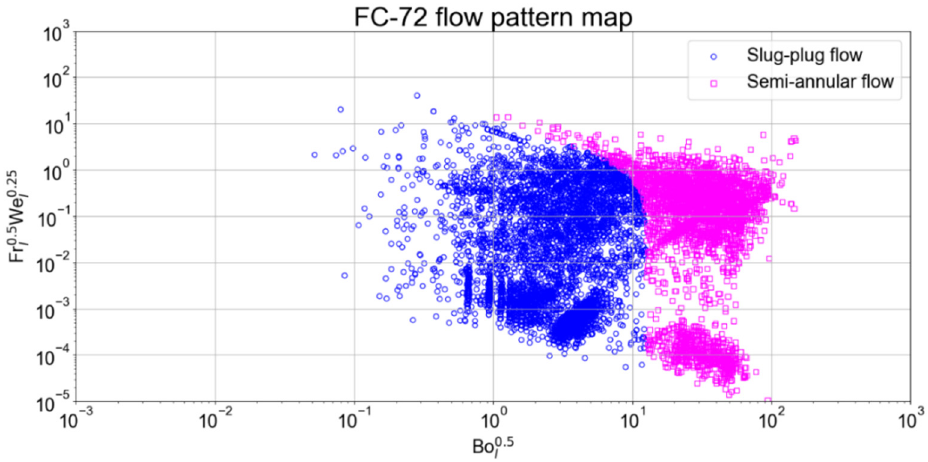
Figure 8. Flow pattern map for FC-72: multilayer perceptron.